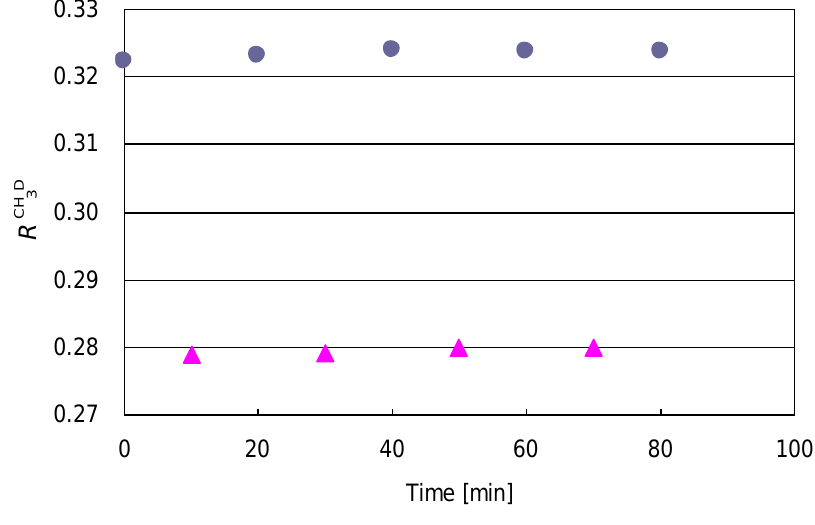
Figure 4. Alternate measurements of the signal ratio of 12 CH standard (circles) and the sample methane